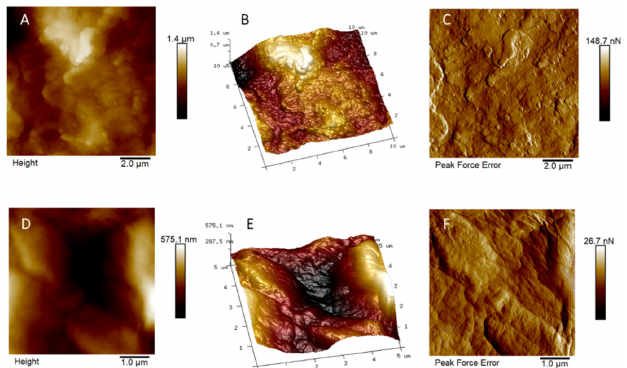
Figure 3. AFM images of ( A , D ) bidimensional and ( B , E ) tridimensional topography, as well as ( C , F ) peak force error of test (upper line) and test + GO discs (lower line). Table 2. Mean values of the absolute values of: the surface high deviations (R a ), the roughness least square value (R q ), the maximum perpendicular distance between the highest and lowest points in the image following the plane fit (R max ), the root-mean square of the surface slope (S dq ), and the percentage of additional surface area contributed by the new texture as compared to an ideal plane of the same region (S dr ), obtained from the five individual measurements using Multimode 8 Bruker AFM and nanoscope analysis software.